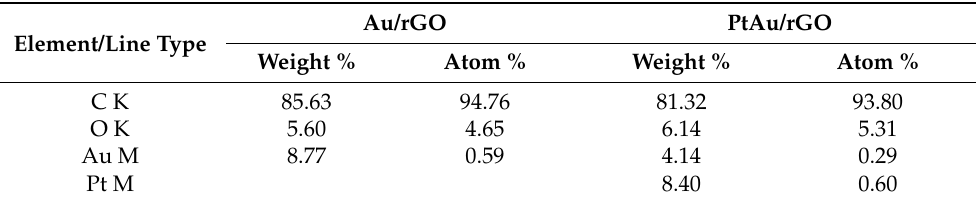
Figure 2. EDS of: ( a ) Au/rGO; ( b ) PtAu/rGO. Table 1. Weight and atomic percentages of C, O, Au and Pt in Au/rGO and PtAu/rGO obtained by